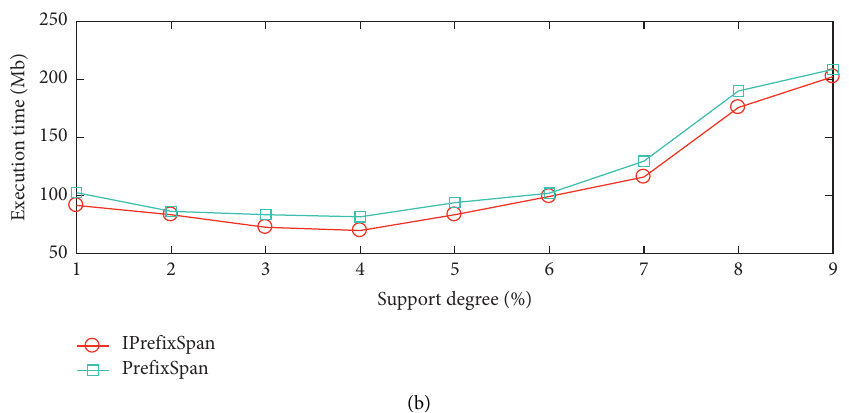
Figure 8: The comparison results compared with the PrefixSpan method.